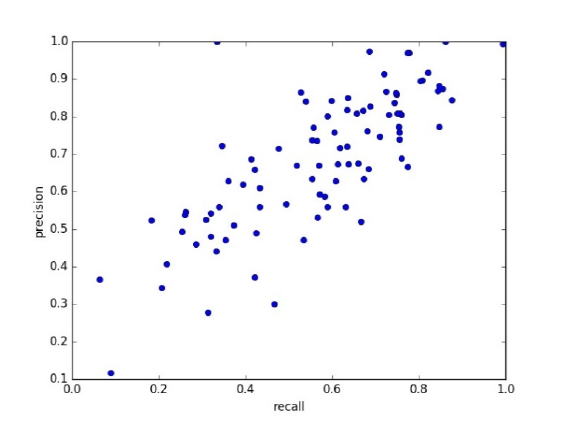
Figure 7. Mean (by request) precision and recall (for fixed threshold) for different classes. Each point represent one of 90 unseen classes